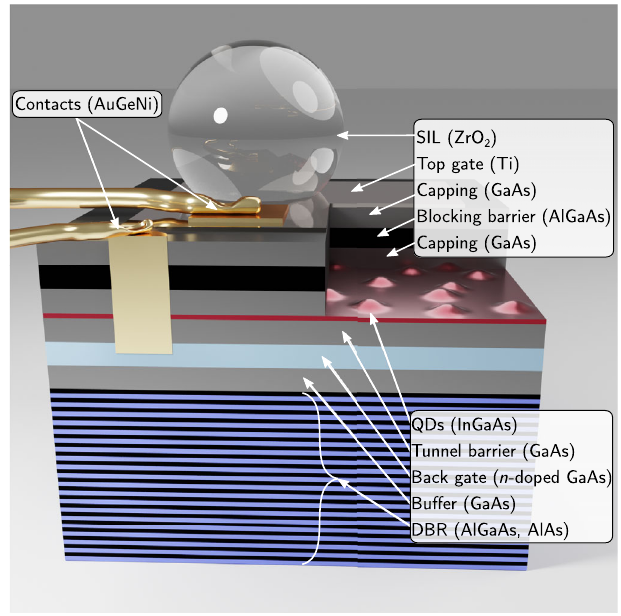
FIG. 6. Sample. A 3D render of the heterostructure of our QD sample (not to scale) with a cutout above the QD layer. A full breakdown of the structure is given in the text. Abbreviations: DBR, distributed Bragg reflector; SIL, solid immersion